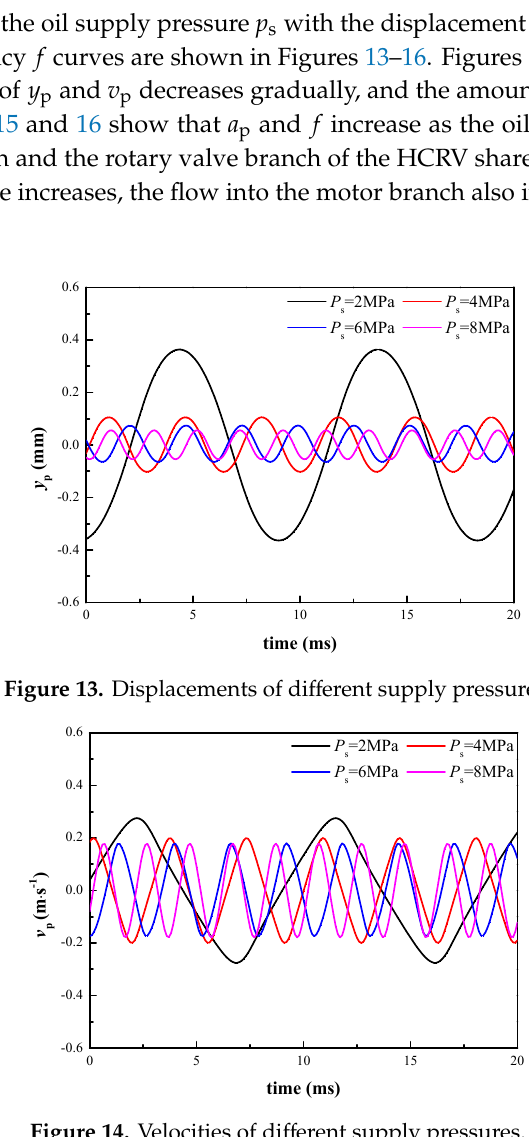
Figure 14. Velocities of different supply pressures.